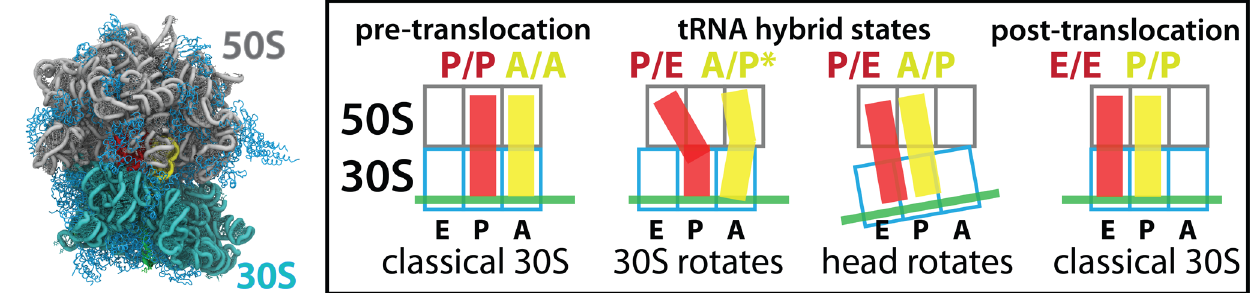
Figure 2. tRNA translocation. Explicit-solvent simulation of an E. coli ribosome (water molecules and ions not shown), colored by region: 23S/5S rRNA (gray), 16S rRNA (cyan), proteins (light blue), P/P tRNA (red) and A/A tRNA (yellow). During translocation, tRNA molecules adopt hybrid configurations (middle). Rotation of the 30S body ( * 7 { 9 0 ) and head ( * 15 { 20 0 ) is associated with tRNA movement between binding sites. Here, we initiated the simulation in the pre-translocation configuration and characterized the structural fluctuations about the classical tRNA configuration and unrotated subunit configuration.